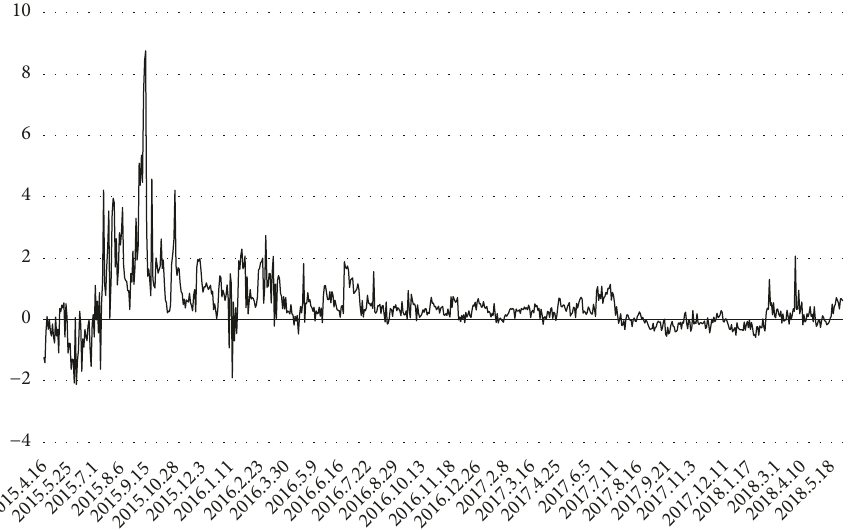
Figure 3: The basis sequence of SSE 50 stock index futures.